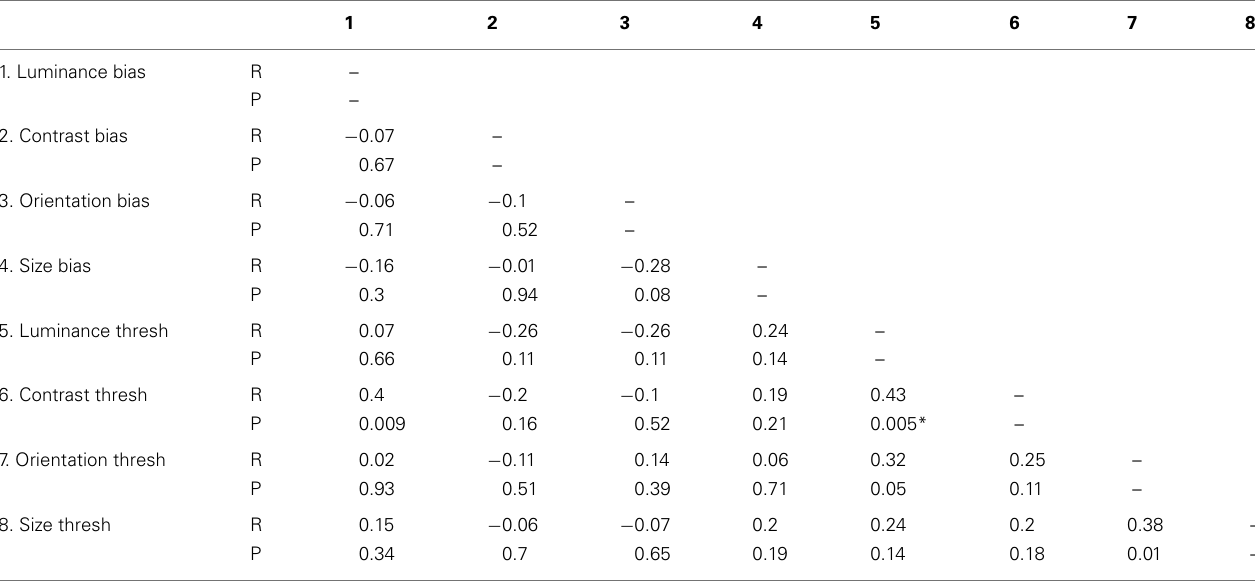
Table 4 | Inter-correlations between biases and thresholds for each of the four tasks tested. 1 2 3